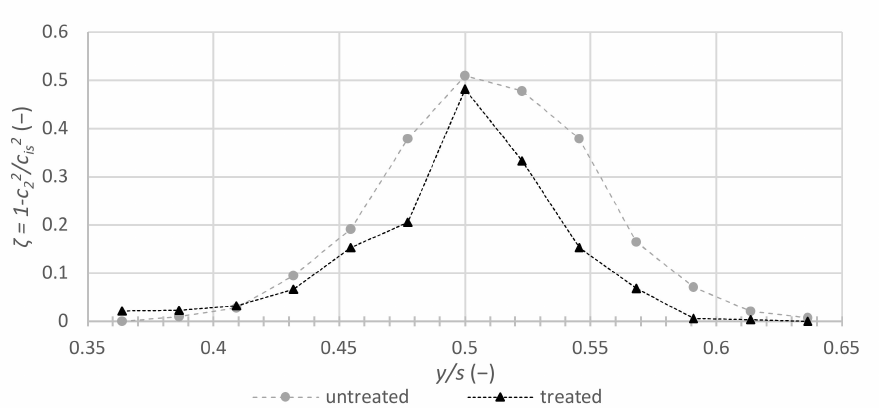
Figure 8. Energy loss coefficient ζ against traverse/space ratio coordinate ( M 2 = 0.68). Table 3. Three different approaches for the loss coefficient and average loss coefficients obtained for Novec 649 at M 2 = 0.68. Untreated State * Treated State * Percentage Loss Coefficient (Original) (Finished)